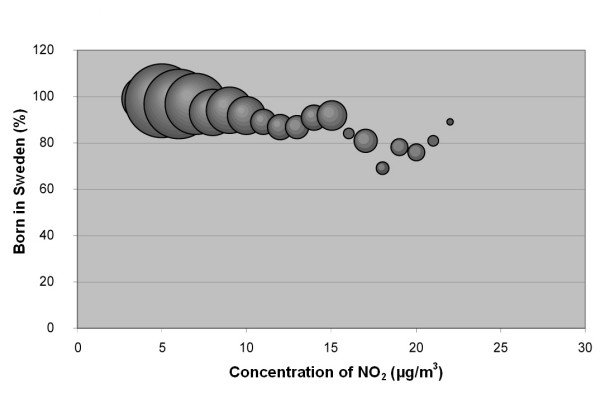
Bubble diagram for Scania; Percentage of population in Scania born in Sweden versus annual mean concentration of NO2 at their real estate. The bubbles are sized according to the weight of the estimate, which depends on the size of the population that the estimate is based on. The weight is thus a measure of the uncertainty in the estimate, and large bubbles represent more certain and influential estimates than small bubbles.